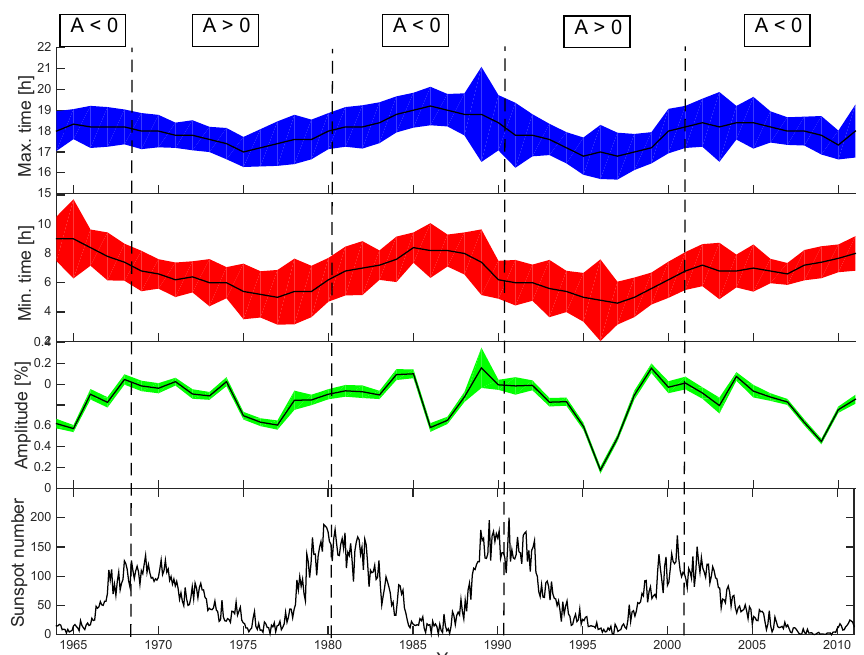
Figure 7. Neutron monitor data is from Newark, USA (37.9 ◦ N, 75.7 ◦ W). Mean times of day of (from top) the maximum in the diurnal variation of neutron monitor counts, the minimum, the mean amplitudes of the variation and the international sunspot number. Shaded regions are the error calculated for individual years as the times. The computation of uncertainties is described in the text. The vertical dashed lines are times of polarity reversal estimate by Thomas et al. (2014a) and the solar magnetic polarity of each cycle is labelled at the